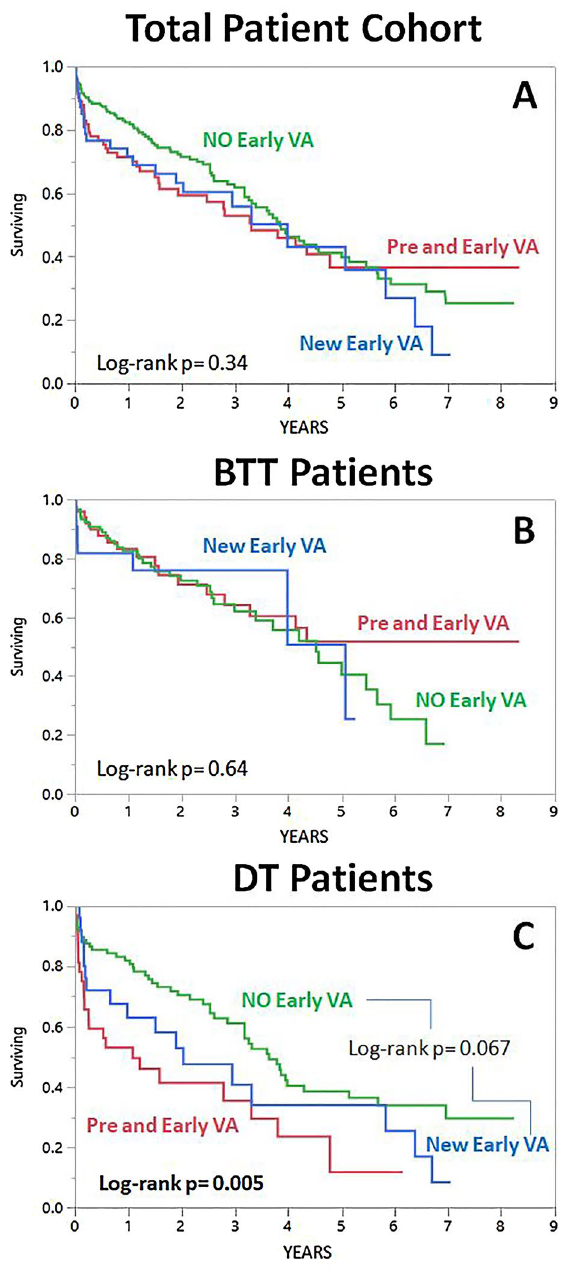
Figure 2. Kaplan-Meyer curves for mortality divided by the existence of new onset early post-LVAD VA (Early post LVAD VA without history of VA prior to LVAD implantation. in all the patient cohort ( A ), the BTT group ( B ) and the DT group ( C